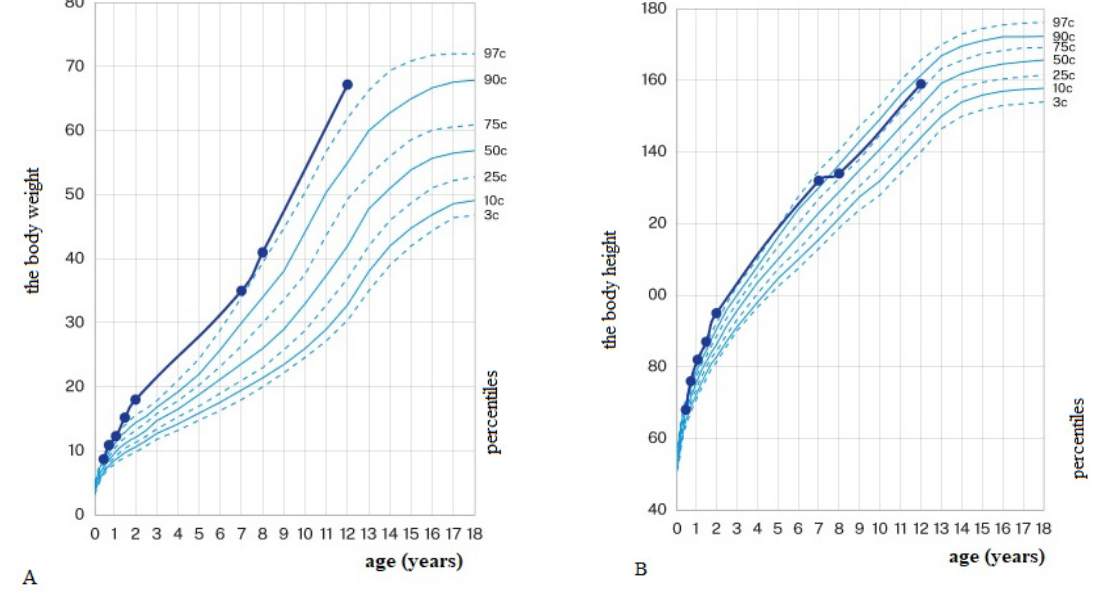
Figure 2. Percentile charts for the body weight ( A ) and the body height ( B